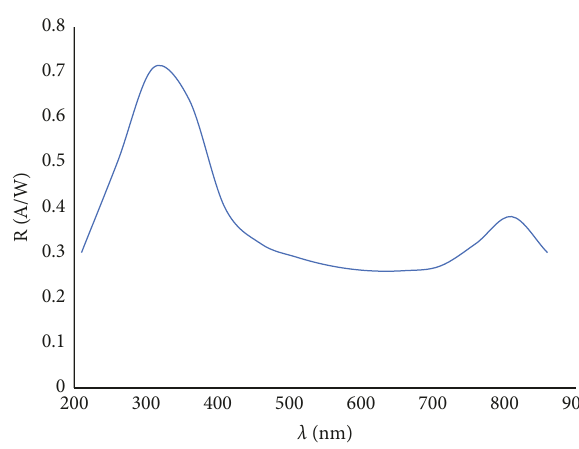
Figure 5: Responsivity of TiO